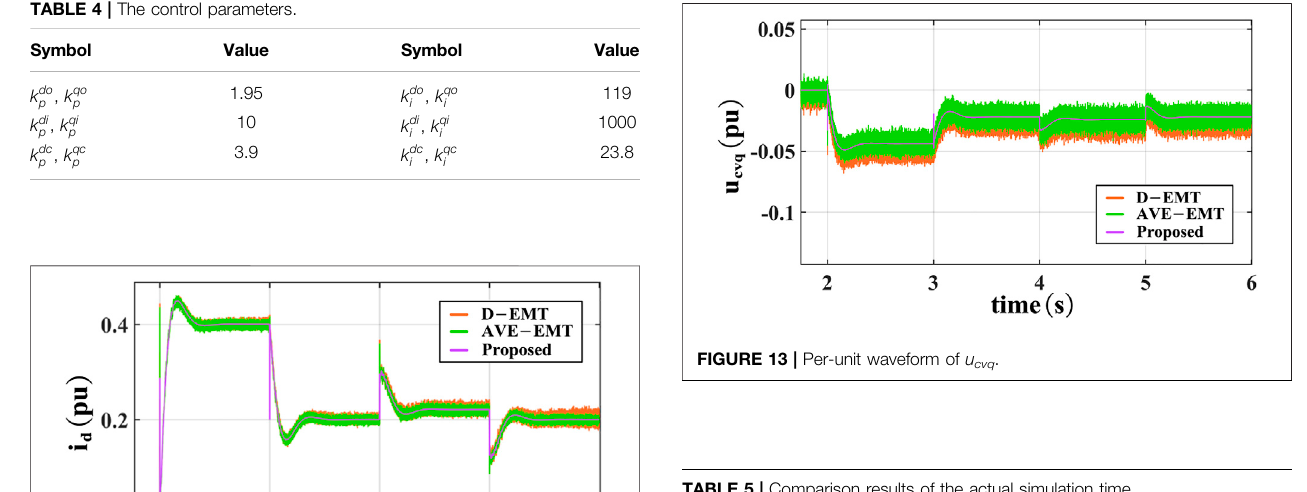
TABLE 5 | Comparison results of the actual simulation time.